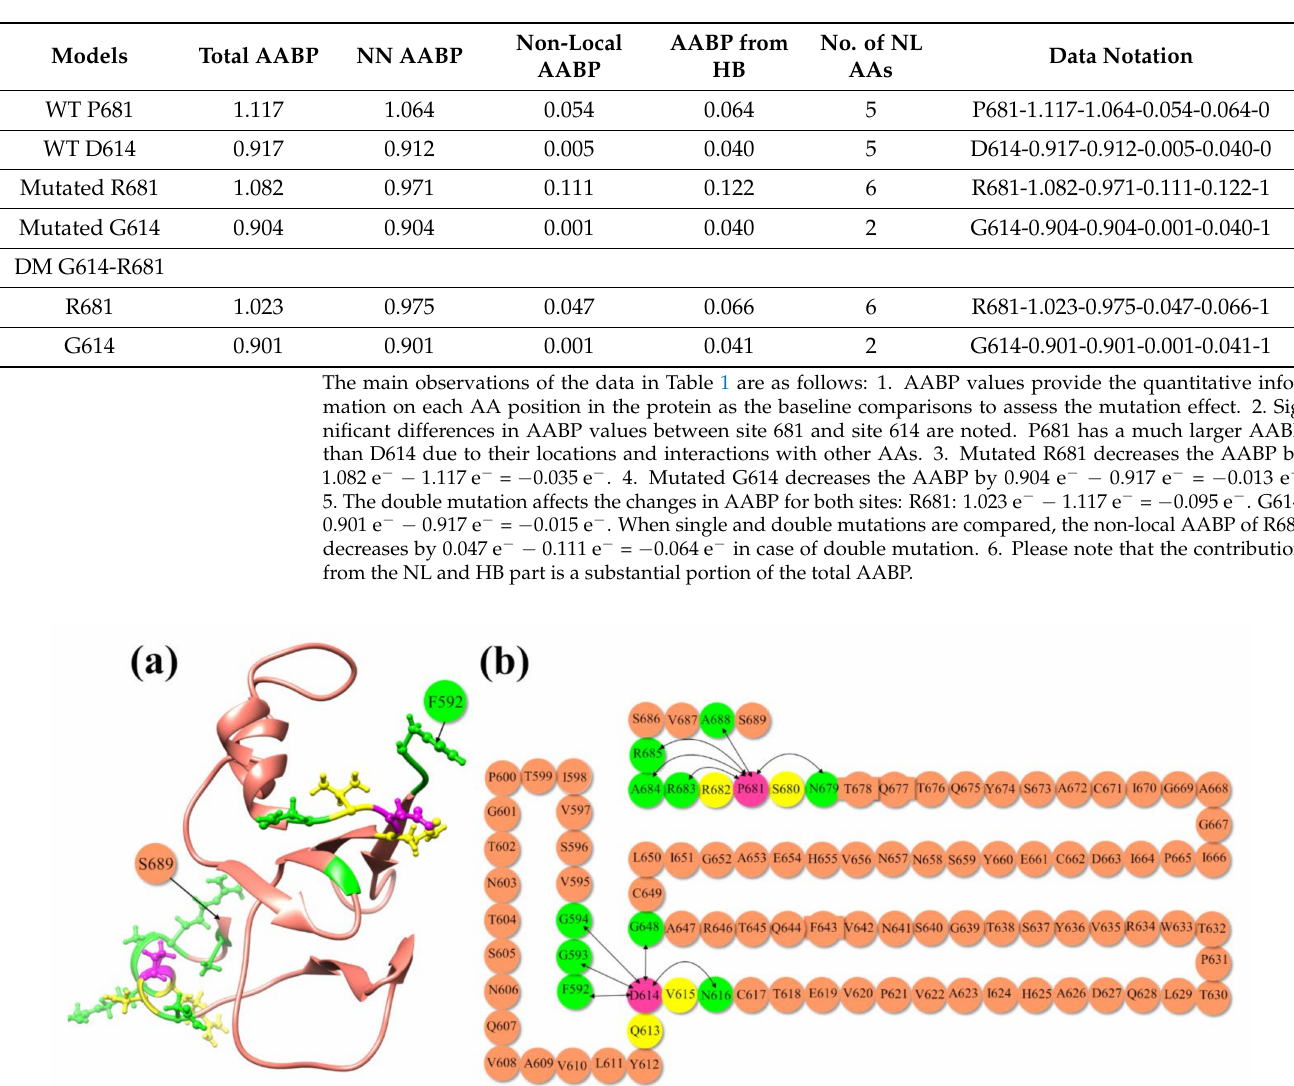
Table 1. AABP of four SD2-FP models and other information. DM denotes double mutation.